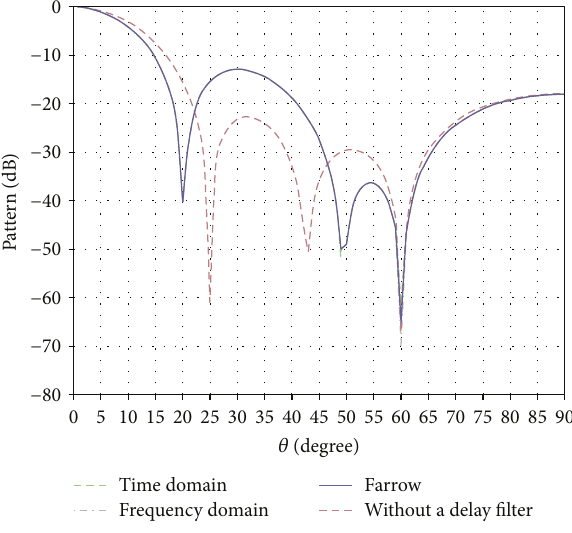
Figure 7: Patterns for broadband beamforming.